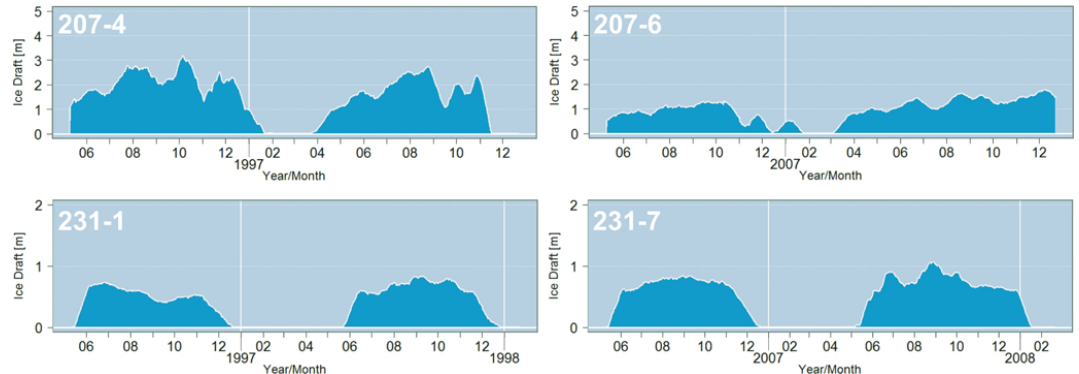
Figure 13. Selected 20-days running averages of daily mean sea ice draft. The dark blue area depicts the sea ice draft corrected by zero-line interpolation. Upper panel: sea ice draft on the position AWI-207, at the tip of the Antarctic Peninsula in the years 1996–1997 (AWI 207-4) and 2005–2008 (AWI 207-6). Lower panel: sea ice draft on the position AWI-231, southwest of Maud Rise in the years 1996–1997 (AWI 231-1) and 2006–2008 (AWI 231-7). For positions see Fig. 2.